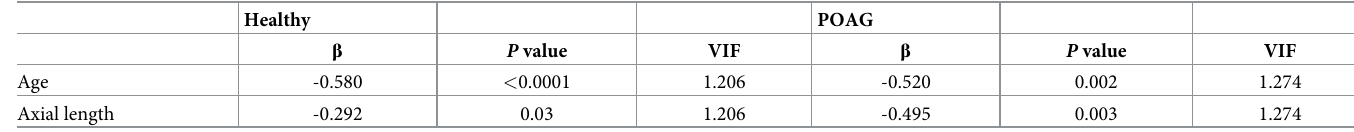
Table 7. Multivariate regression analysis of macular choroidal luminal area with associated factors. Healthy